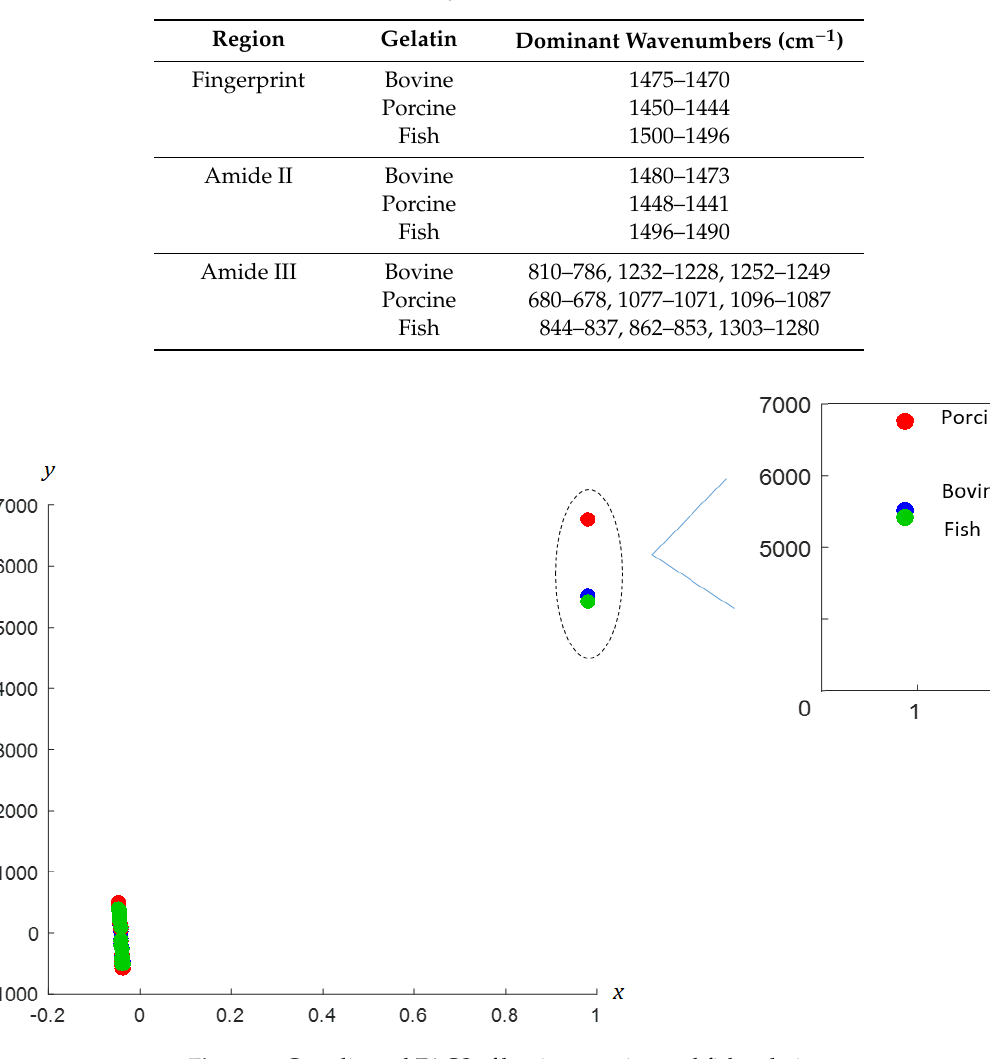
Figure 5. PCA ( a ) score and loading plots ( b ) for gelatins at fingerprint region. The performances of c-FACS and PCA are summarized in Table 3. The c-FACS is found to be faster, with elapsed time of 7.86 s than PCA (12.86 s) for analysis involving bovine, porcine and fish